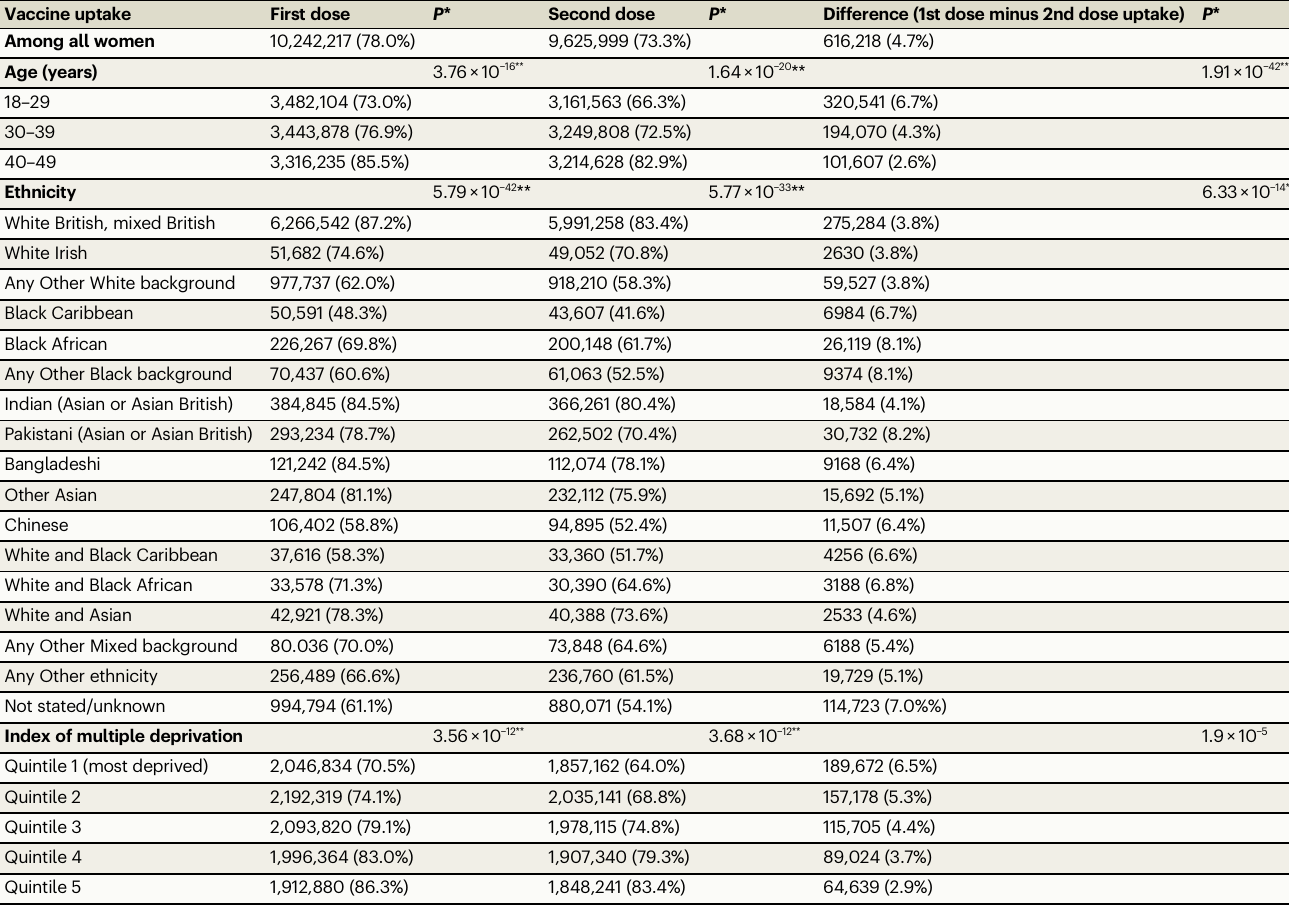
Table 2 | Completeness of COVID-19 vaccination among women of reproductive age (18 – 45 years), by the week of